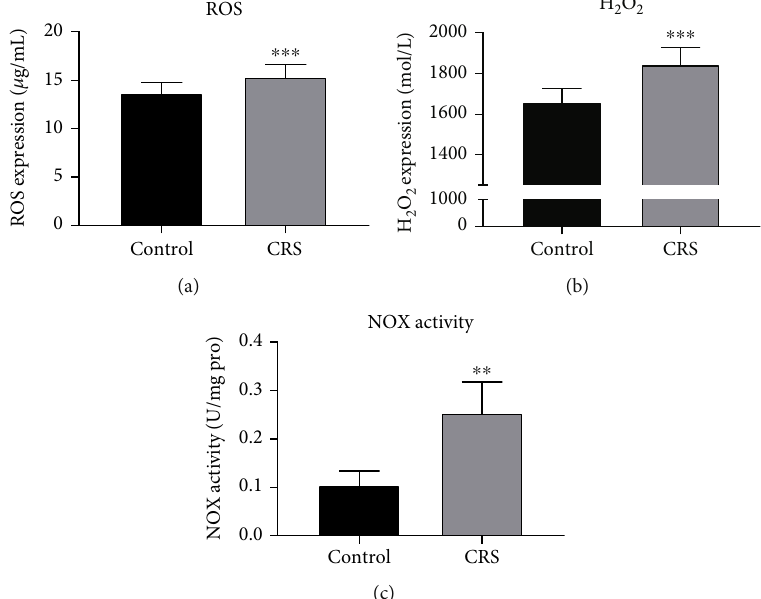
Figure 4: CRS increased oxidative stress and NOX activity in the brain microvasculature of mice. (a) ROS production was increased upon mental stress in the vessels of brains through ELISA. (b) Total H could induce an upregulation in NOX activity. Values are mean ± SE . ∗∗ p < 0 : 01 , ∗∗∗ p < 0 : 001 , as compared with the control